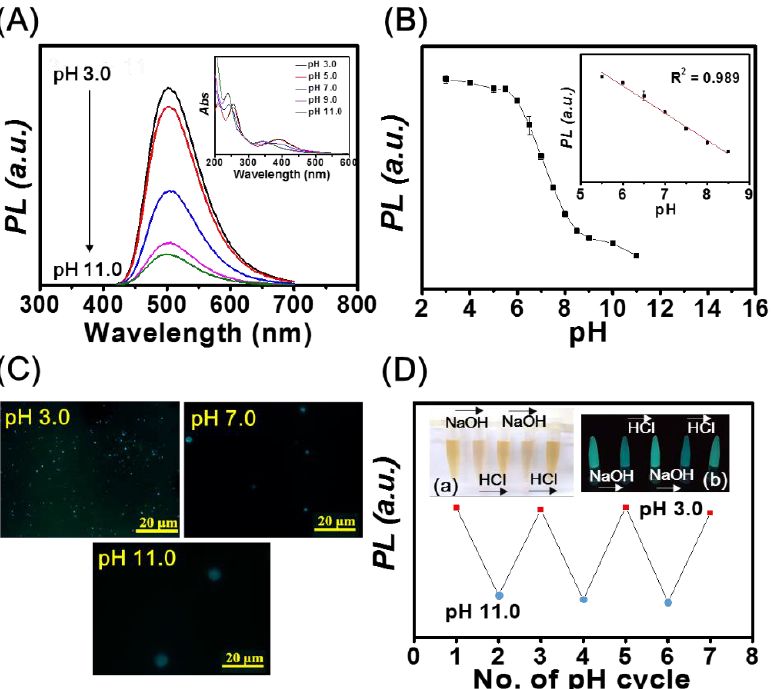
Figure 2. ( A ) Fluorescence spectra of mPA CNPs (1 µ g mL − 1 ) at pH values of 3.0, 5.0, 7.0, 9.0, and 11.0. Inset: Corresponding UV-Vis spectra of mPA CNPs (1 µ g mL − 1 ). ( B ) Plot of the fluorescence intensity at 500 nm versus pH values. ( C ) Fluorescence microscopic images of mPA CNPs at pH 3.0, 7.0, and 11.0. ( D ) The fluorescence intensity of mPA CNPs at 500 nm cycled between pH 3.0 and 11.0. Inset: Corresponding photographs under (a) white light and (b) UV light. The pH of the mPA CNPs solution is switched back and forth between 3.0 and 11.0 by using 0.1 M HCl or NaOH solutions, respectively. Excitation and emission wavelengths are 400 and 500 nm,